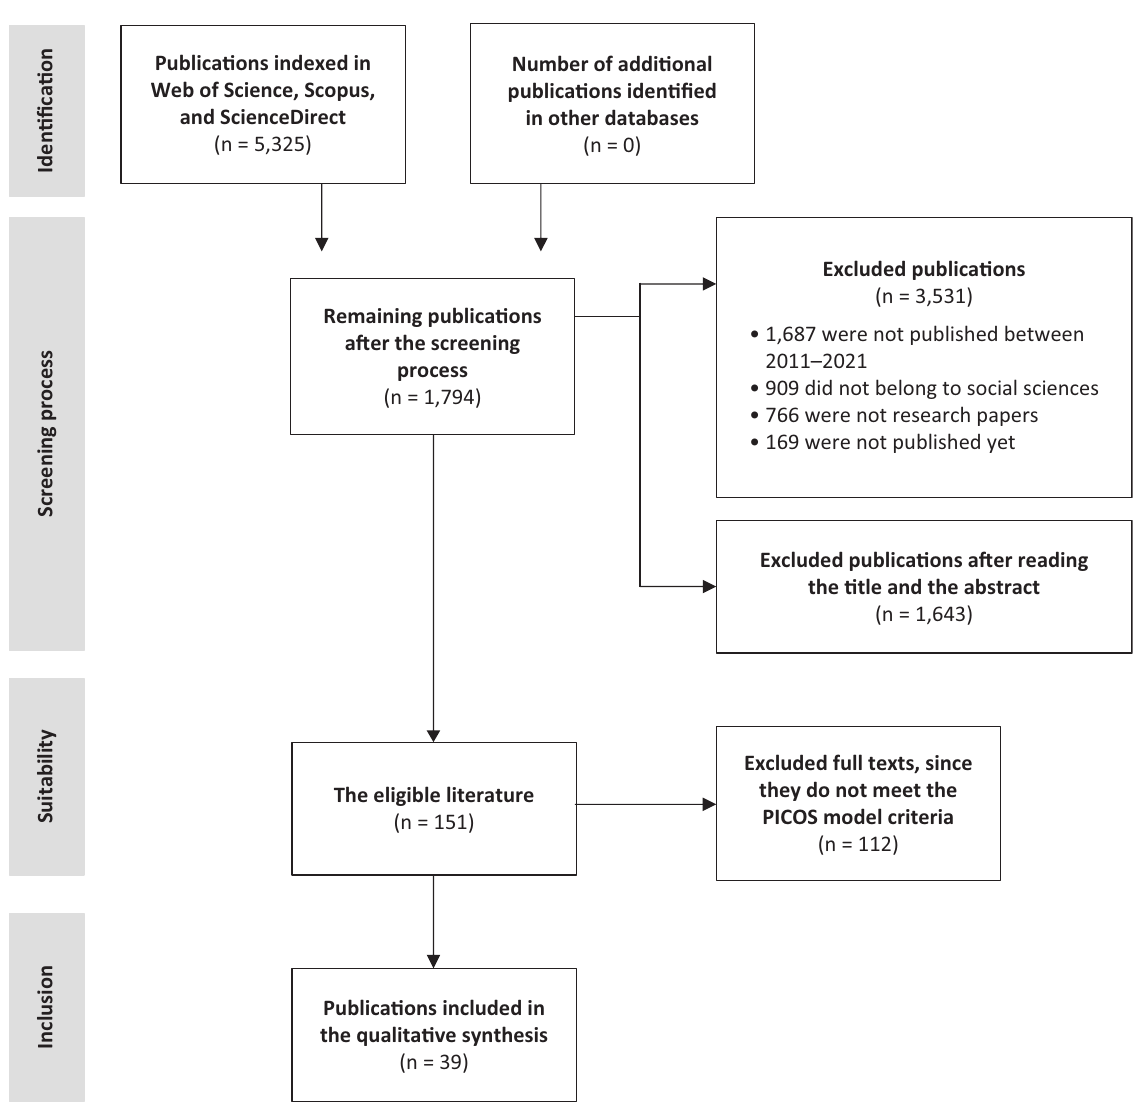
Figure 3. Planning, identification, and eligibility process workflow.